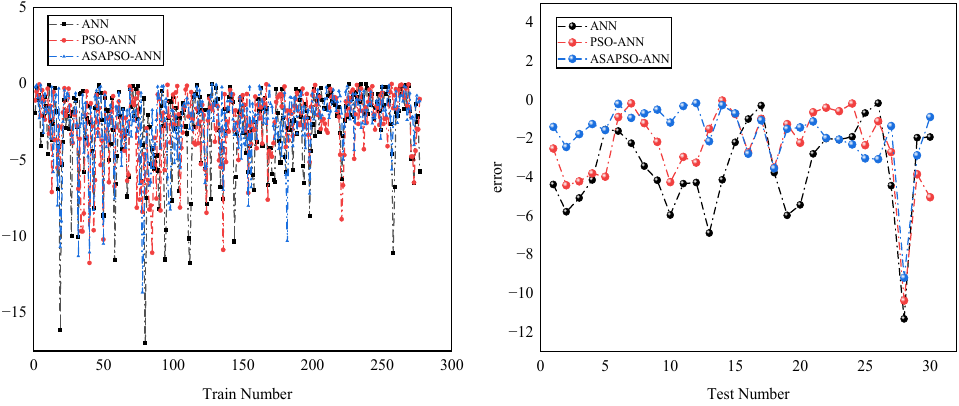
Figure 10. Comparison of errors in the training ( right ) and testing ( left ) sets of three models.